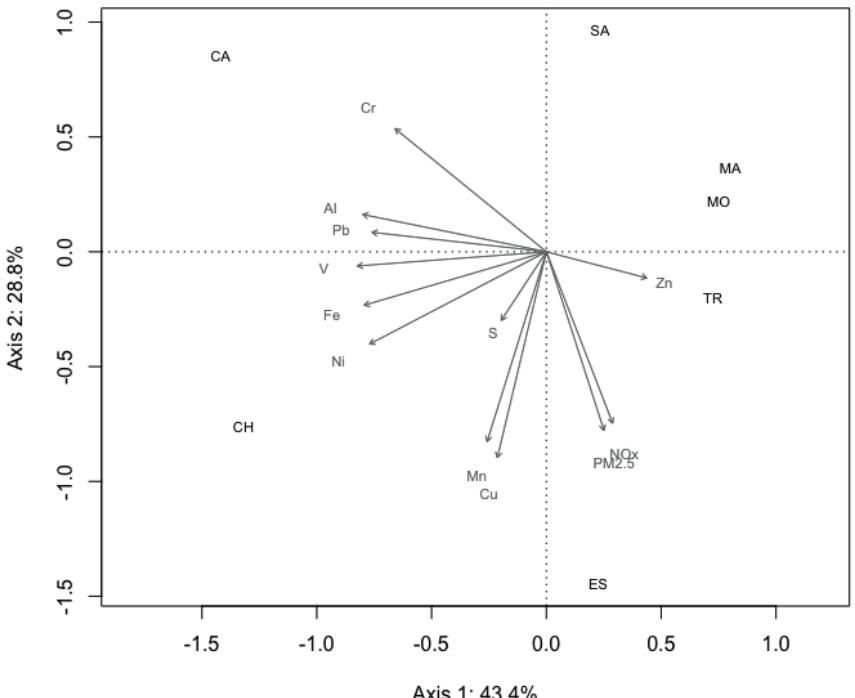
Figure 4 - Diagram of ordination of a PCA (Principal Component Analysis) based on a matrix of sites (cities) described by the pollution variables. Sites are the black letters and the variables, the grey ones. Abbreviations: CA = Caraá, CH = Charqueadas, TR = Triunfo, MO = Montenegro, MA = Maquiné, SA = Santo Antônio da Patrulha, ES = Esteio, Cr = Cromium, Al = Aluminum, Pb = Lead, V = Vanadium, Fe = Iron, Ni = Nickel, S = Sulphur, Mn = Manganese, Cu = Copper, PM2.5 = PM , NOx = NO 2.5 x